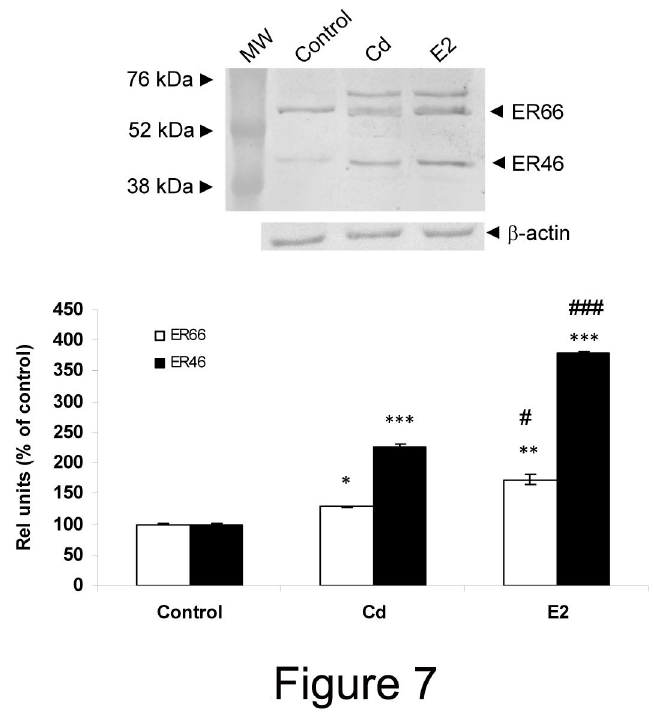
Figure 7. Cadmium exposure increases ERα. protein expression in anterior pituitary cells . Anterior pituitary cells were treated with vehicle (control), 10 nM Cd or 1 nM E2 for 24h. A representative western blot is shown. Bars represent the mean ± SE of densitometric values of full-length ERα (open bars) and ERα46 (black bars) normalized to β-actin expression and are expressed as percent of control. ANOVA followed by Tukey-Kramer’s test, *p<0.05, **p<0.01, ***p<0.001 vs. respective control; #p<0.05, ###p<0.001 vs. Cd (N=3).